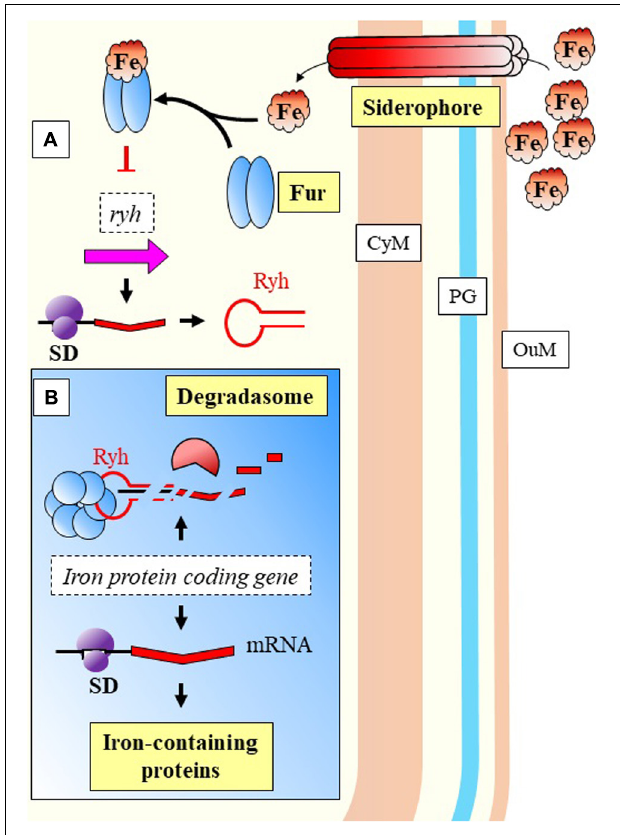
FIGURE 6 | Nutritional immunity response in E. coli . (A) Excess of extracellular iron is bound to Fur protein that inhibits transcription of Ryh. (B) Ryh can inhibit the synthesis of proteins containing iron when this element is limited due to nutritional starvation exerted by the host. Ryh negative regulation is mediated by Hfq, binding to the target mRNAs directing the activity of the degradasome. CyM, Cytoplasmic membrane, OuM, Outer membrane; PG, peptidoglycan. Black thick arrows indicate flow of a biological process, e.g., protein translation. Red thick arrows with flat cap indicate inhibition (equal for red thick dashed